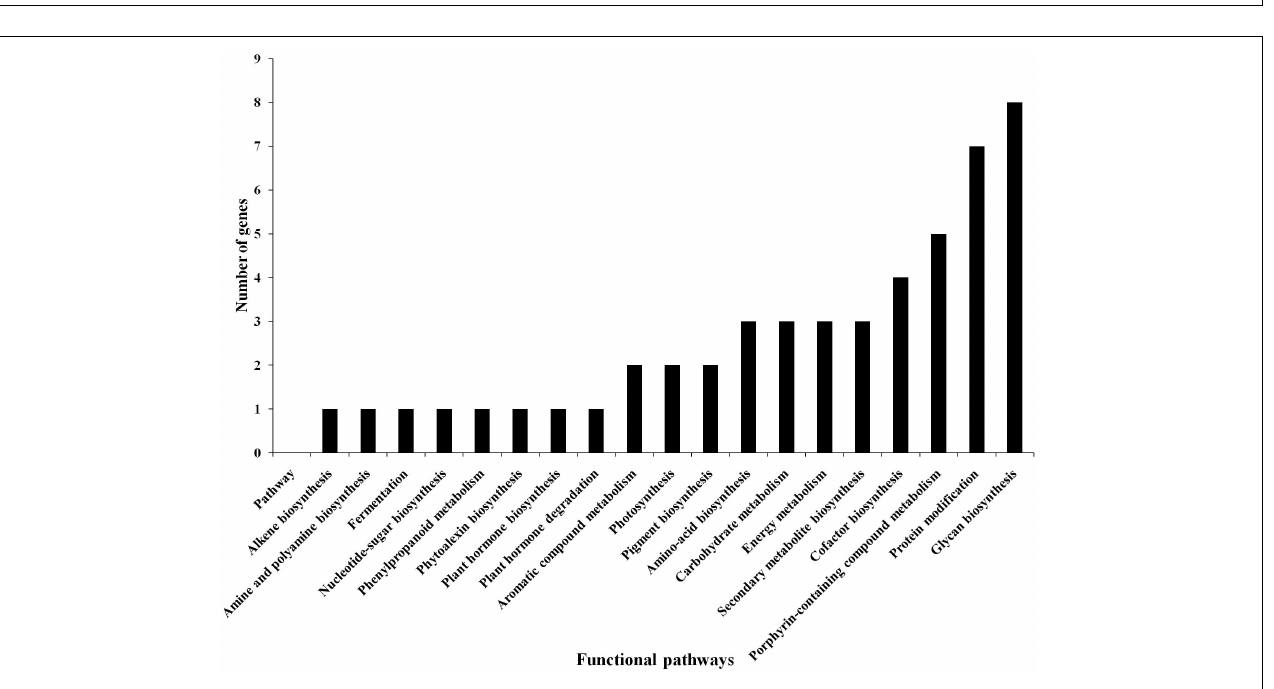
FIGURE 1 | (A) Venn diagram showing the unique (non-overlapping region) and common expressed genes (overlapping region) obtained when drought-stressed rice is compared with T. harzianum- treated + drought-stressed rice. (B) Volcano plot representing significant and non-significant differentially expressed gene (DEG)-based p values. The green dot represents the significant